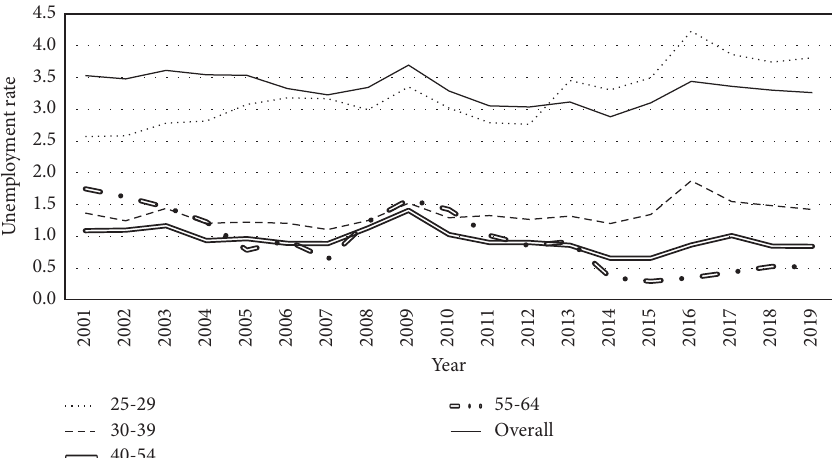
Figure 1: Unemployment rate (%) based on age group in Malaysia. Source: authors’ computation from the Rating Agency Malaysia (2020)